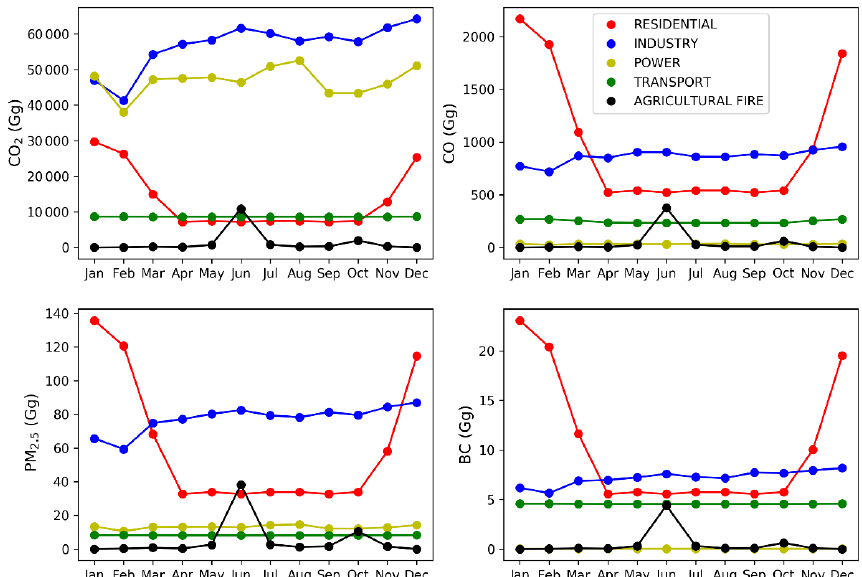
Figure 9. Comparison of monthly CO 2 , CO, PM 2 . 5 , and BC emissions from agricultural fires with those from other emission sources (residential, industry, power, transport; data source: Li et al., 2015) in the intensive burning area (32–36 ◦ N, 112–122 ◦ E) of eastern China in the year